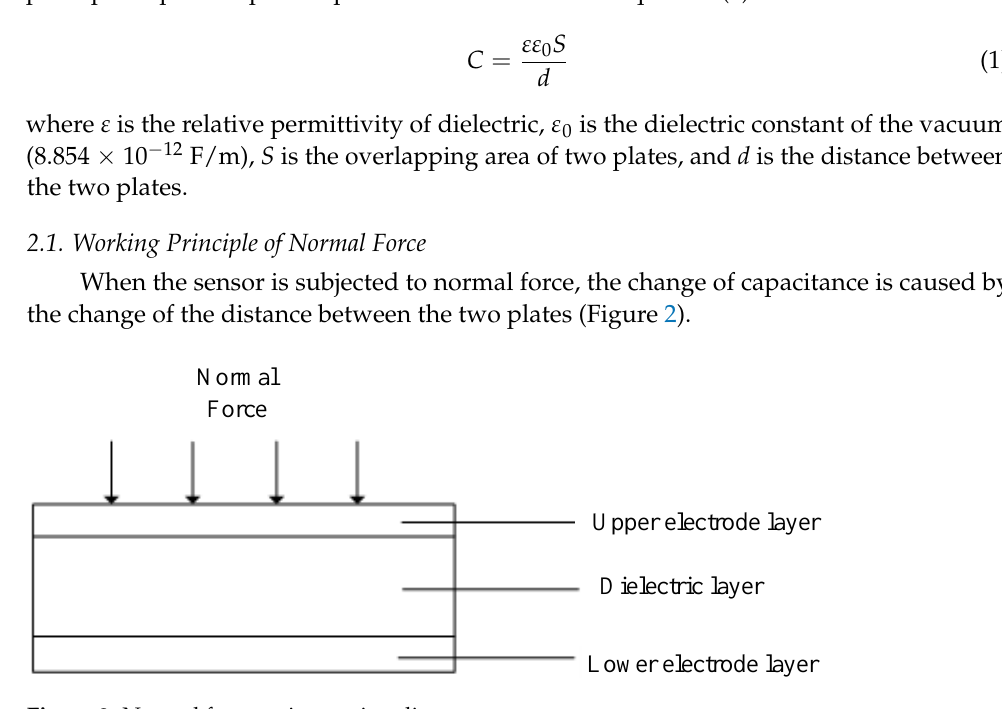
Figure 2. Normal force action testing diagram.